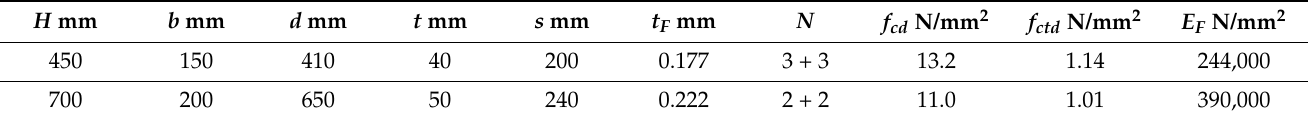
Table 3. Geometric and mechanical characteristics of the two case studies. Symbols used for the tee cross-sections (T-beams): overall depth H , width of the web b , effective depth d , concrete cover t , and thickness of the flange s . The width of the flange plays no role, so it is not provided (any width is possible). Symbols used for the FRP reinforcement: thickness of each layer of reinforcement t F , total number of layers N , and elastic modulus E F . Symbols used for the concrete: cylinder compressive strength f cd and cylinder tensile strength f ctd